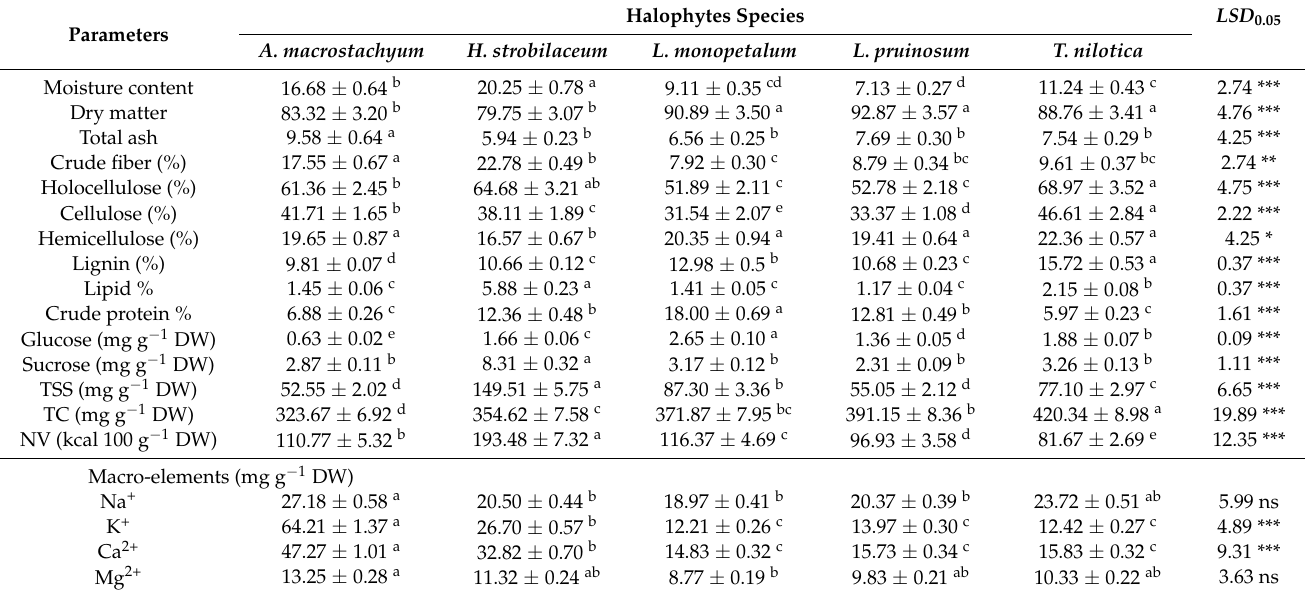
Table 2. Proximate composition, fiber fractionations, and mineral composition of studied